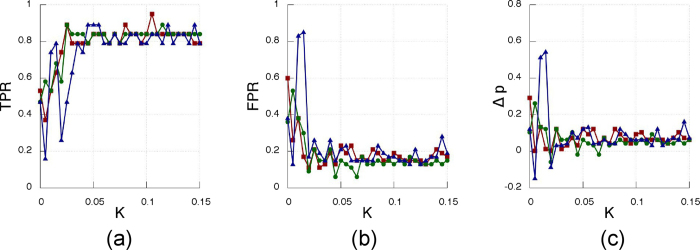
As in Fig. 9 but for the phases computed via a Hilbert transformation.